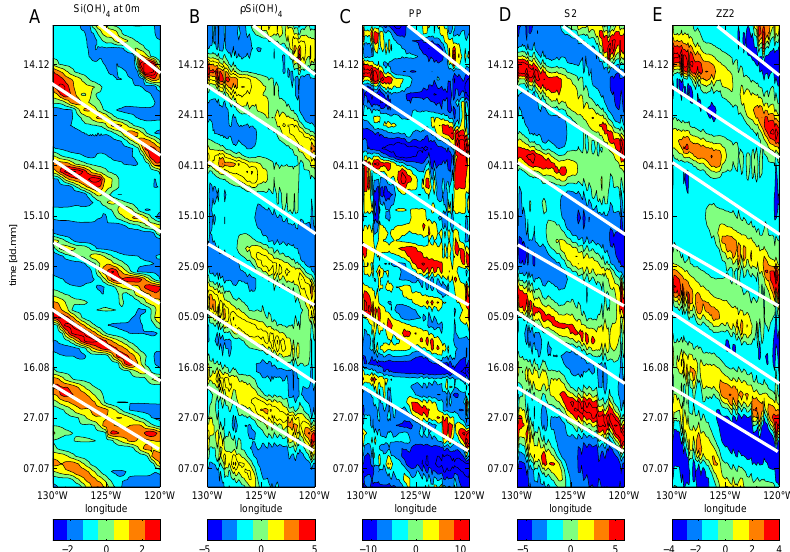
Fig. 9. Same as in Fig. 8 but panels from left to right show the unfiltered variability (mean removed) in: (A) surface Si(OH) 4 concentration (mmolSim − 3 ) (same as in Fig. 8e but with fewer contours, repeated for ease of direct comparison), (B) ρ Si(OH) 4 (mmolSim − 2 d − 1 ), (C) PP (mmolCm − 2 d − 1 ), (D) S2 and (E) ZZ2 biomass (mmolNm − 3 ). White lines are the probable TIW tracks translated from Fig.